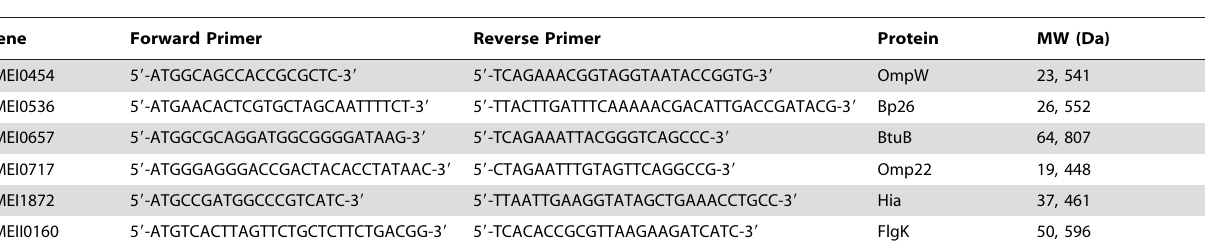
Table 1. Brucella melitensis 16M Genes and Proteins.